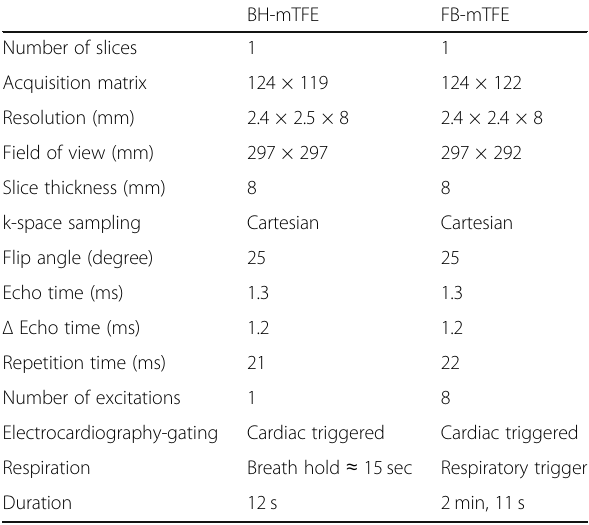
Table 1 Imaging parameters for breath-holding (BH-mTFE) and free-breathing (FB-mTFE)